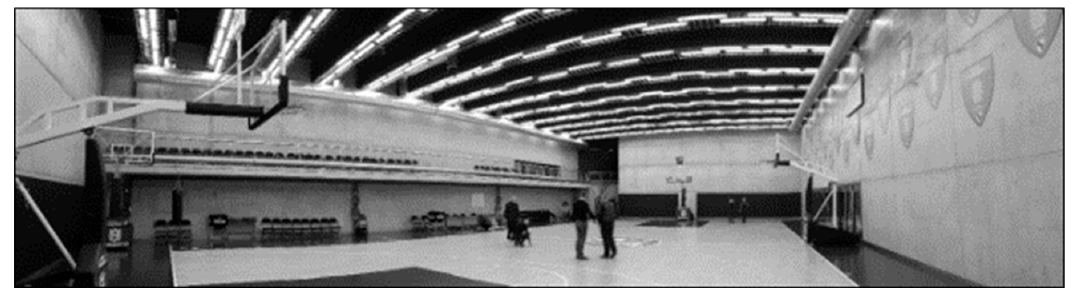
Figure 1. Basketball training hall view.